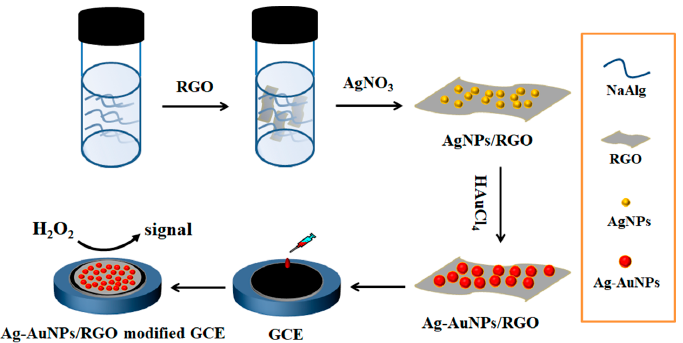
Scheme 1. Schematic illustration of synthesis of Ag-AuNPs/reduced graphene oxide (RGO) and its application in the electrochemical detection of H 2 O 2 .